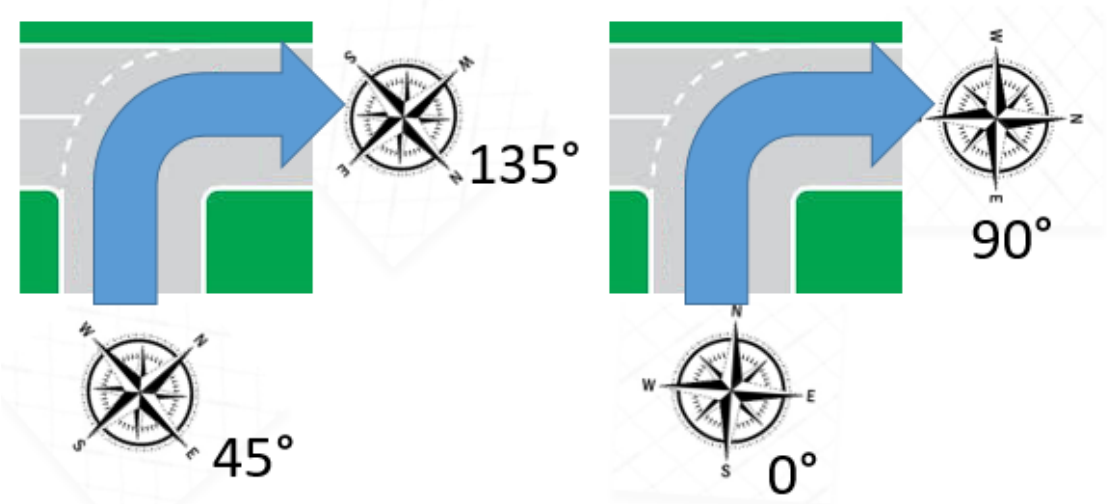
Figure 3. Left figure: compass is misaligned (parcel tracking use case) and heading goes from 45 ◦ to 135 ◦ . We only know that the relative heading is therefore +90 ◦ , e.g., a turn to the right. Right figure: compass is aligned (bicycle tracking use case) and heading goes from 0 ◦ to 90 ◦ . We now know the tracker went from South–North to East–West on the road